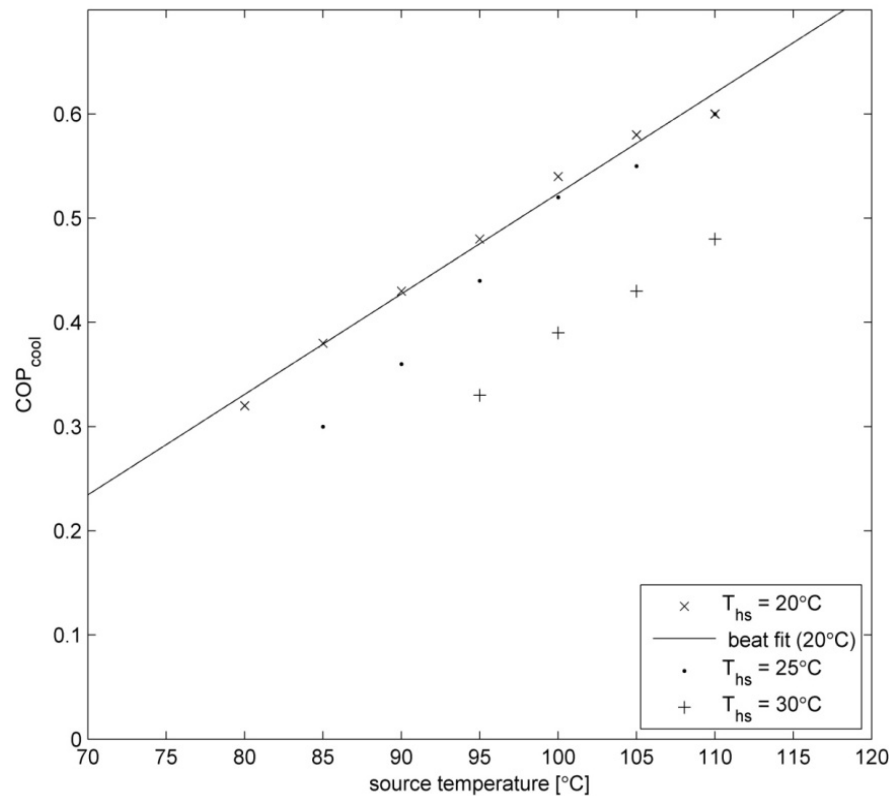
Figure 5. COP against heat source temperature for 22 °C cooling temperature.